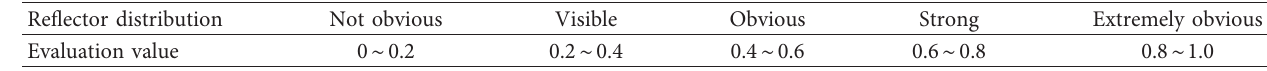
Figure 3: Two-dimensional results map of advanced geological prediction. Table 1: Selection rule of reflection surface coefficient.